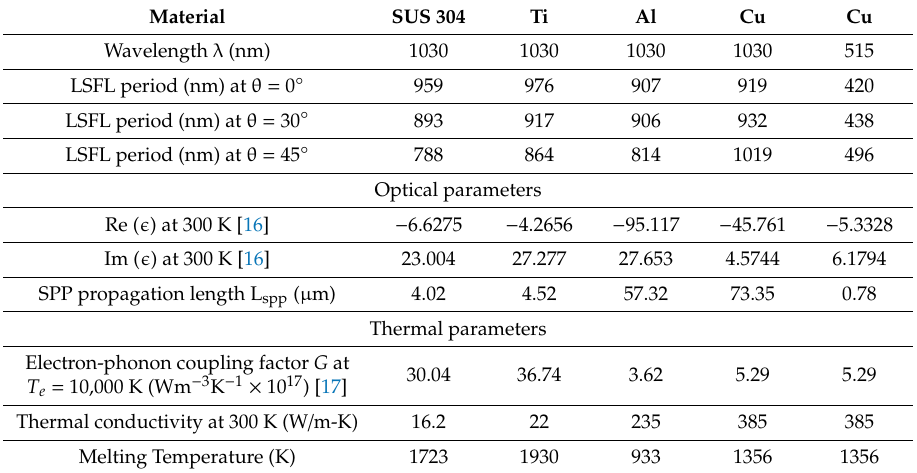
Figure 2. SEM images of the LSFL generated by the line scanning process for the four different metals irradiated by 1030 nm laser with different θ (0°, 30°, and 45°): ( a – c ) SUS 304, ( d – f ) Ti, ( g – i ) Al, and ( j – l ) Cu. Table 1. Summary of LSFL experimental results and material related optical and thermal parameters.